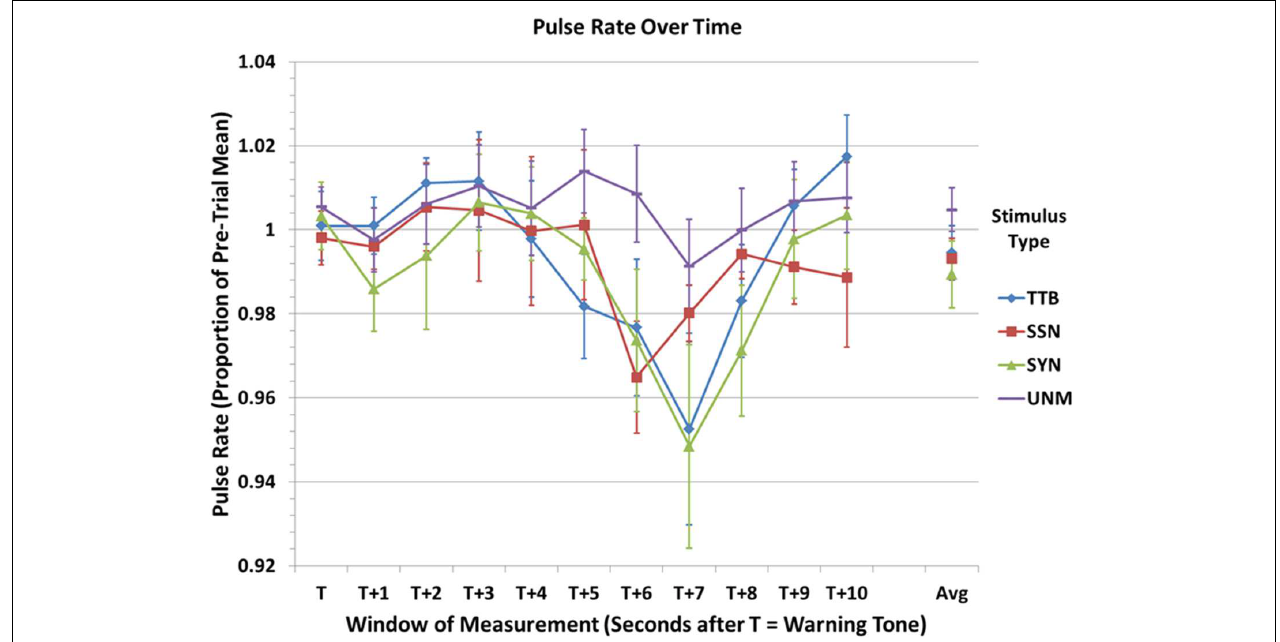
FIGURE 2 | Mean pulse rate (PR) at 1 s intervals over a 10 s window of analysis beginning at the warning beep at the start of the trial, expressed as a proportion of the mean PR calculated over the 2 s immediately preceding the onset of the trial. TTB, natural speech masked with two-talker babble; SSN, natural speech masked with speech-shaped noise; SYN, unmasked computer synthesized speech; UNM, unmasked natural speech. Error bars indicate standard error of the mean. See text for statistical